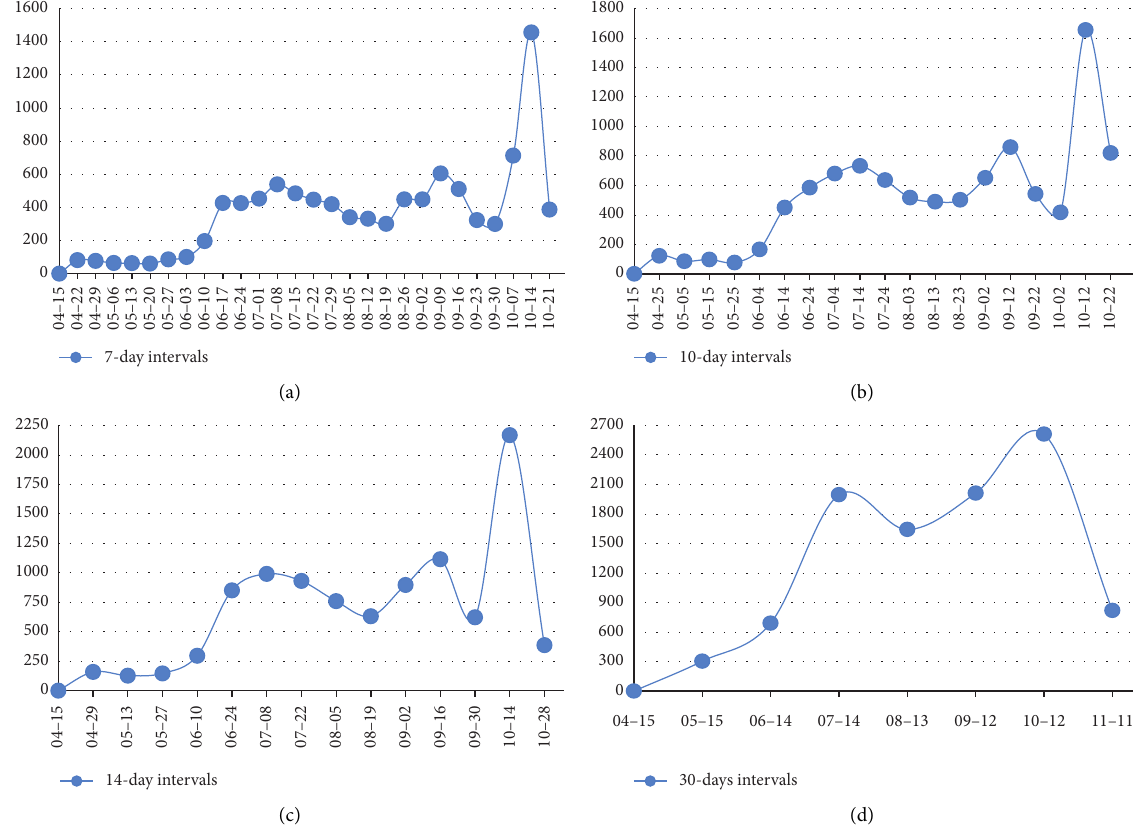
Figure 2: Trend chart of the number of reviews in different time intervals. (a) Trend graph of the review number at 7-day intervals. (b) Trend graph of the review number at 10-day intervals. (c) Trend graph of the review number at 14-day intervals. (d) Trend graph of the review number at 30-day intervals.